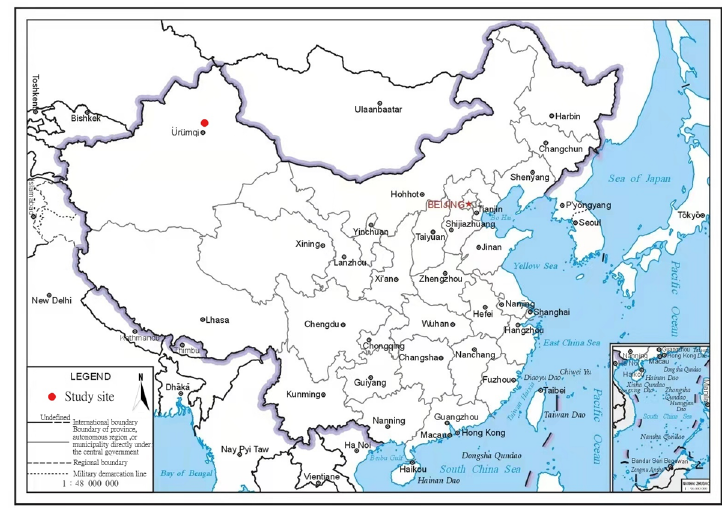
Figure 1. Geographical location of the study site.